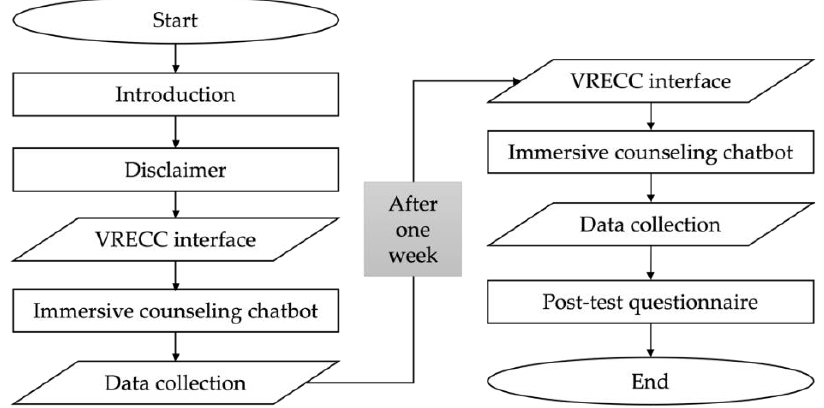
Figure 9. The VRECC experiment pre- and post-experiment survey flow.